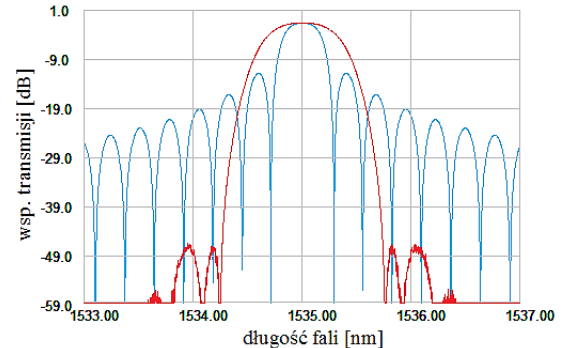
Fig. 12. Comparison of Bragg fiber gratings spectral characteristics without apodization – blue line and apodized cosine function for wsp. А = 3 – red line.